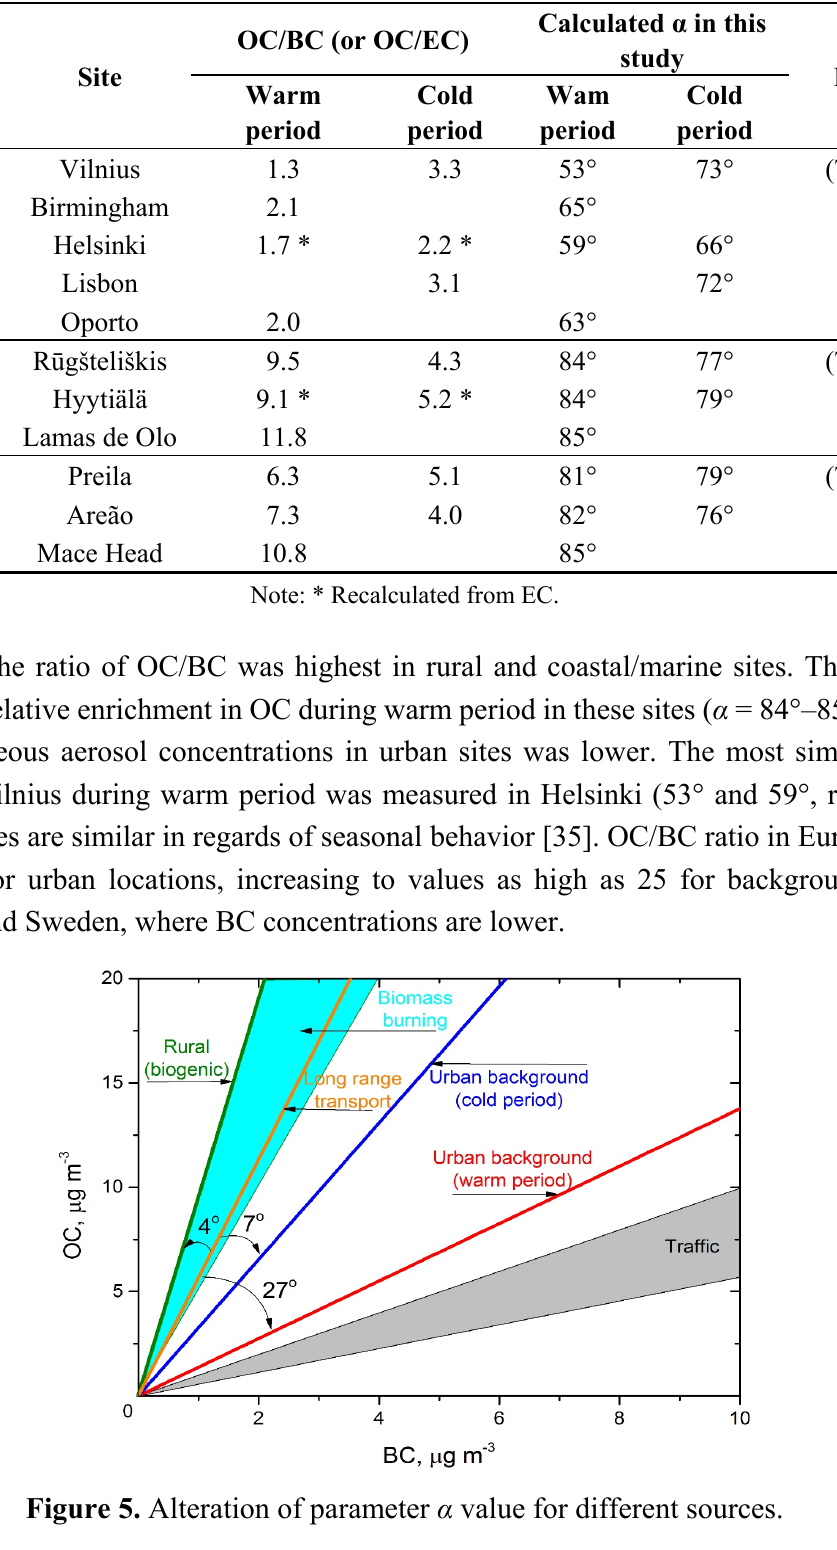
Table 2. Values of parameter α at the various sampling sites in Europe.